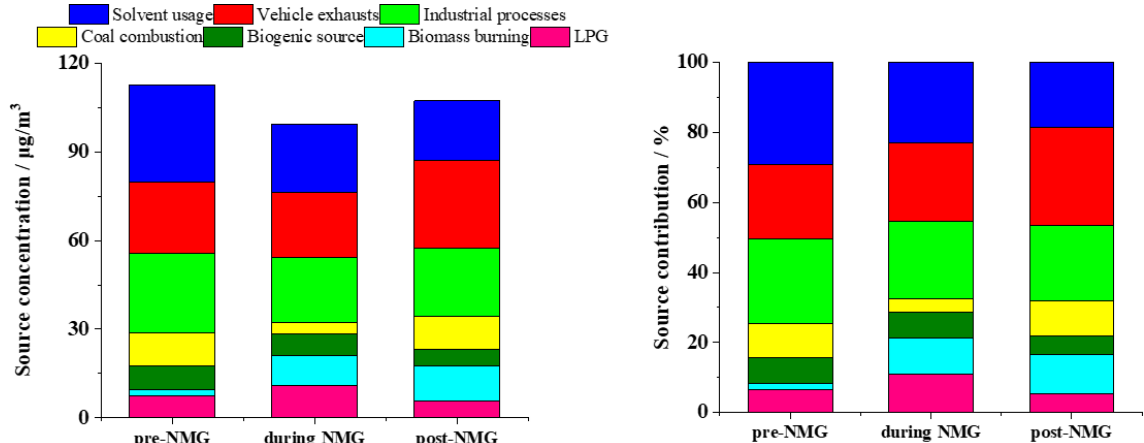
Figure 6. Source contributions to VOC concentration in the PMF model during the three periods.